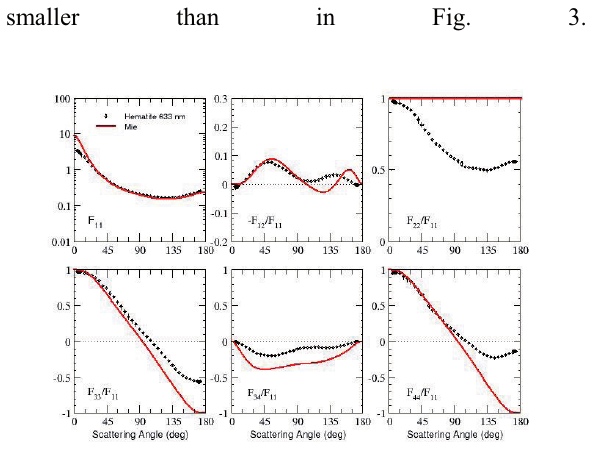
Fig. 4 Measured scattering matrix elements as functions of the scattering angle of hematite at 632.8 nm. The measurements are presented together with results of Lorenz-Mie calculations for